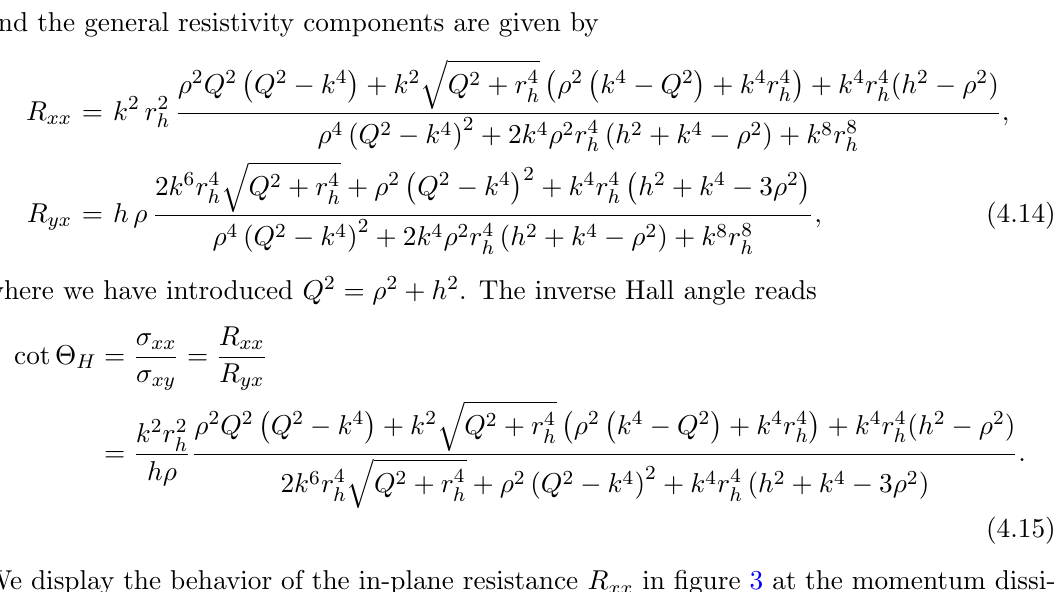
Figure 3 . The resistance R xx at (cid:12)nite charge density as a function of h=(cid:26) and T= the momentum dissipation parameter k= correspond to decreasing values of h=(cid:26)